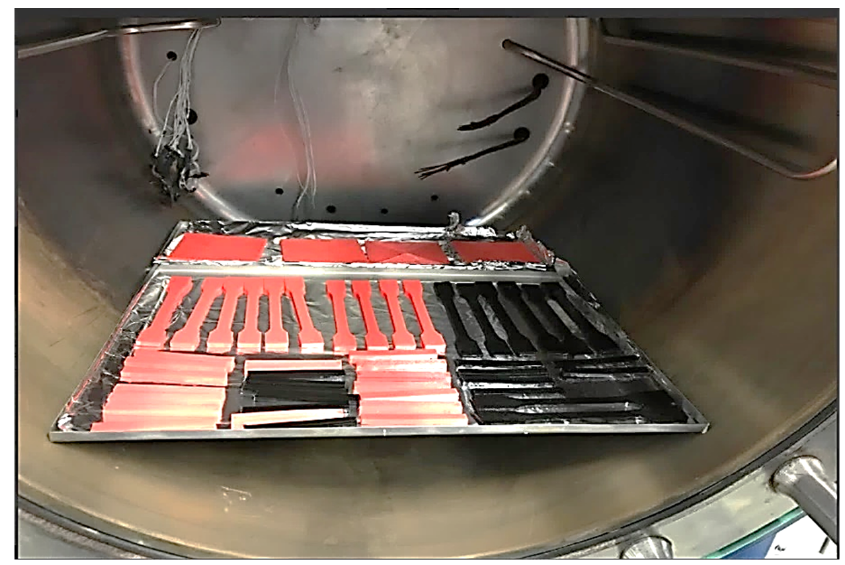
Table 2. Showing trails and parameters of autoclave pressurization with temperature of PLA sam- ples, both injection-molded and 3D-printed.